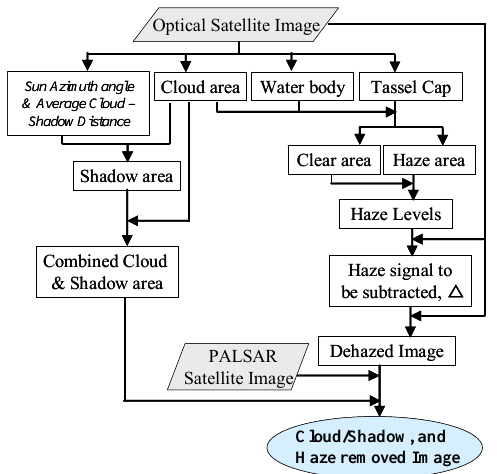
Figure 1. General Workflow for Identification and Removal